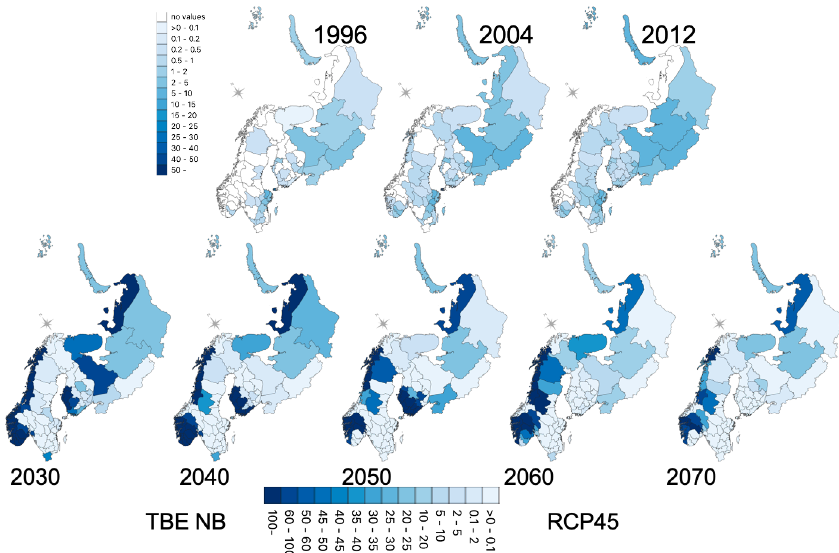
Figure 11. Tick-borne encephalitis (TBE): ( top ) historical period, seven-year averages around each reported year; ( bottom ) projected incidences (seven-year averages) after negative binomial modelling using vegetation types and climate variables, and RCP4.5 land surface model